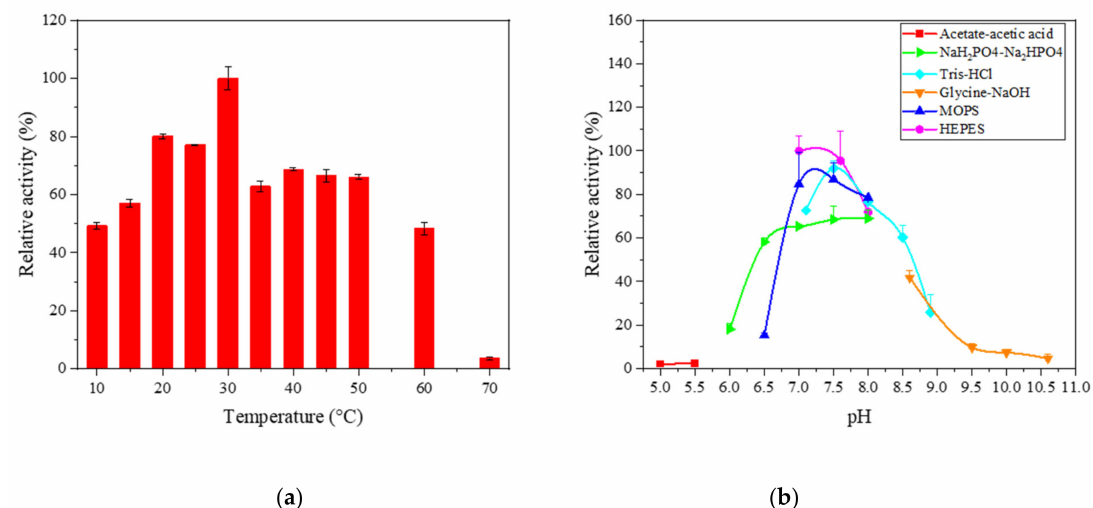
Figure 1. Temperature ( a ) and pH dependence ( b ) profiles for the hydroxylation activity by BAMF2522. All results were expressed as means ± SD of at least two separate experiments (numerical data with errors are given in Tables S2 and S3). In temperature dependence experiments ( a ), reactions contained (in 0.5 mL total volume) 0.6 mM substrate (C15:0), 4.0 µ M enzyme, 0.2 mM NADPH (nicotinamide adenine dinucleotide phosphate) and 5% ethanol. Assays were carried out at varying temperatures for 15 min, with a shaking speed of 500 rpm in 50 mM Tris-HCl, pH 7.5 buffer. The activity value at 30 ◦ C was defined as 100%. In the case of pH dependence experiments, after pre-incubation with different buffers, the reactions were carried out at 30 ◦ C for 15 min at 500 rpm shaking speed. Reactions contained (in 0.5 mL) 1 mM substrate (C15:0), 4.0 µ M enzyme, 0.2 mM NADPH and 5% ethanol. The activity value at HEPES (4-(2-hydroxyethyl)-1- piperazineethanesulfonic acid), pH 7.0 was defined as 100%. MOPS; (3-(N-morpholino)propanesulfonic acid).